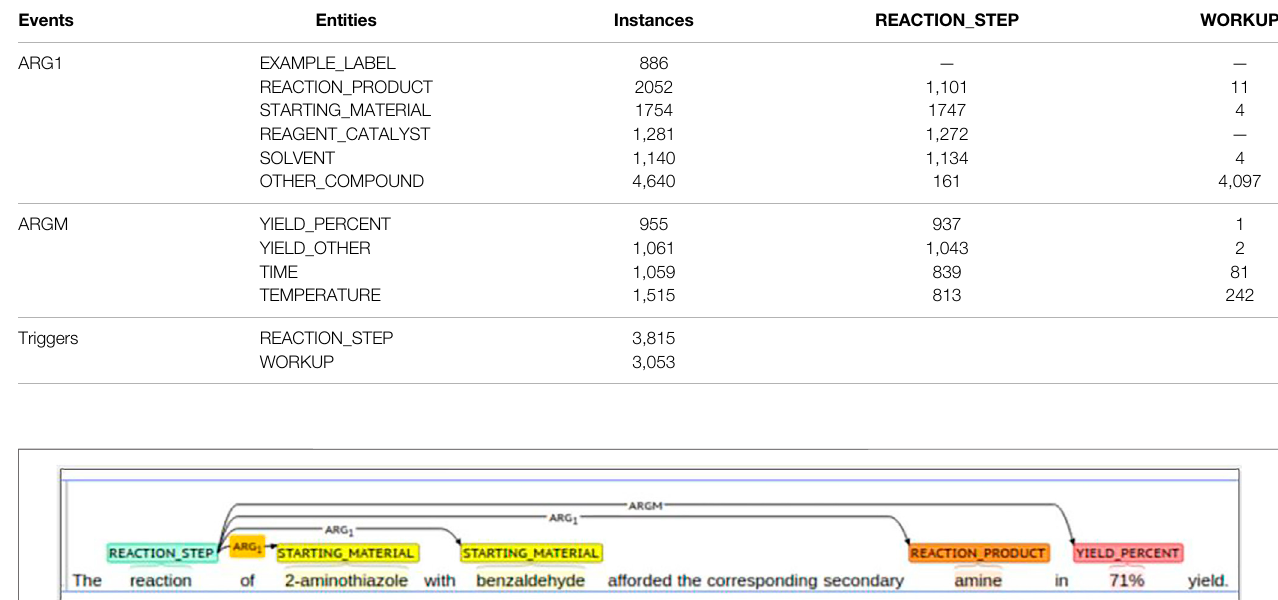
TABLE 2 | Number of entity types and trigger words in the training data and their event relations.